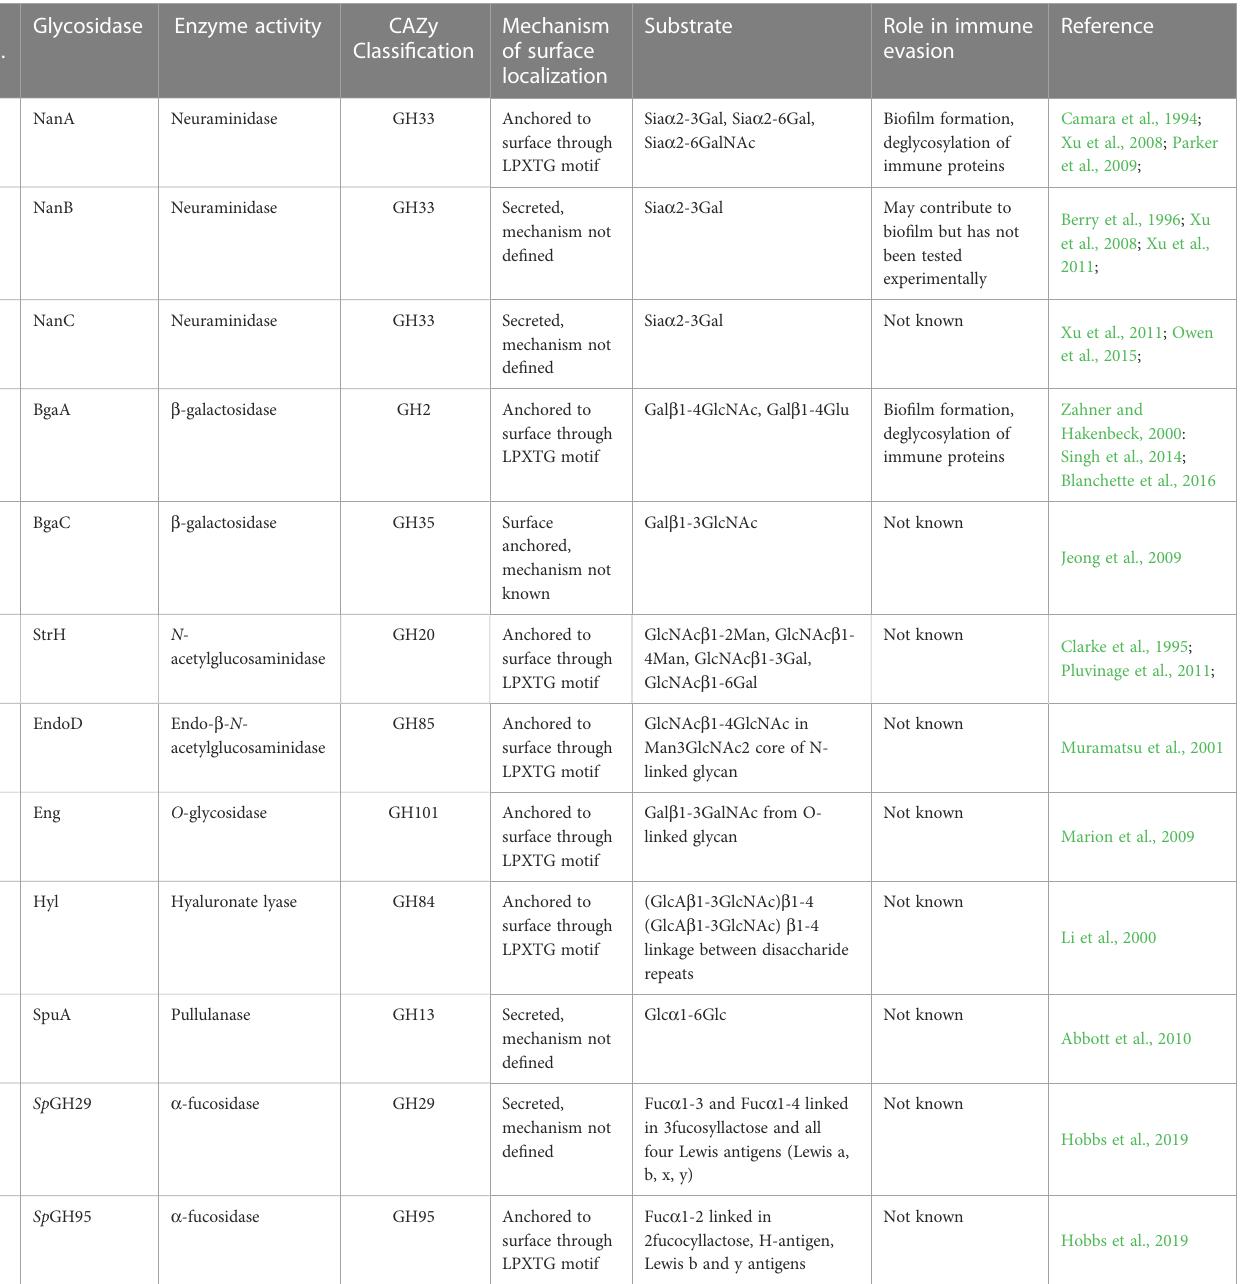
TABLE 1 Extracellular glycosidases of S. pneumoniae . Sl.